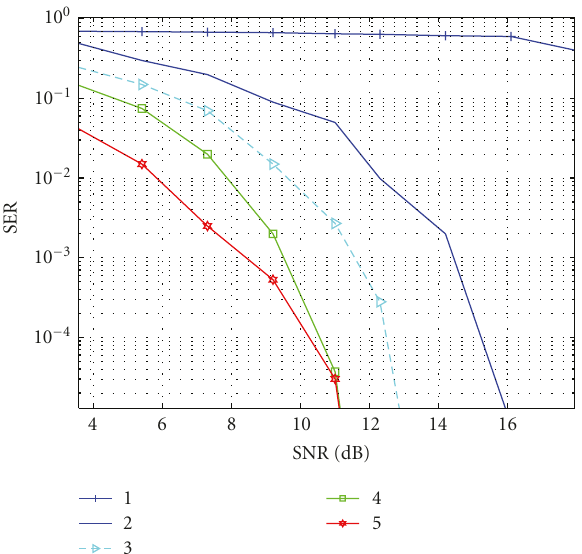
Figure 5: SER comparison for di ff erent equalizers. (1) Proposed algorithm without improvements discussed in Section 6, (2) L´opez- Valcarce’s Method in [11] without denoising. (3) L´opez-Valcarce’s method in [11] with matrix denoising. (4) Improved proposed algorithm by the POR ( m = 3) method, (5) Improved proposed method by the hybrid ( m = 2)